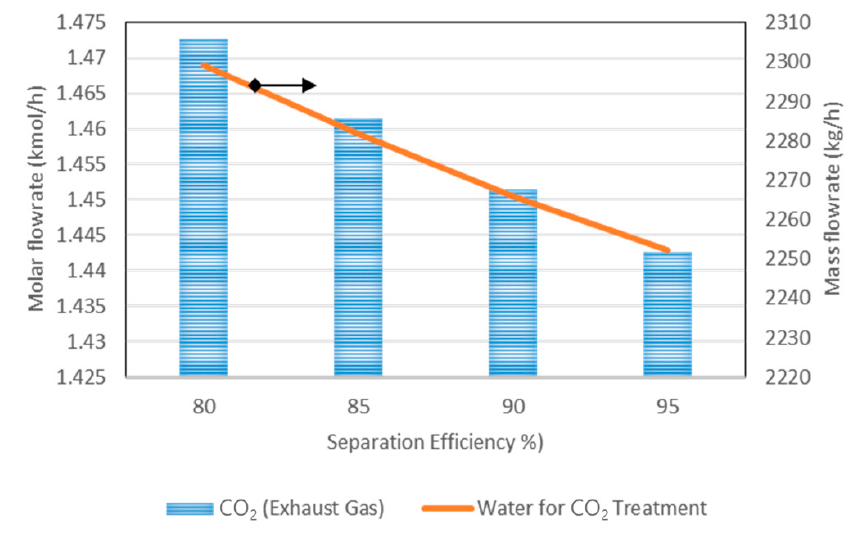
Figure 14. E ff ect of Separation e ffi ciency on CO 2 generated and water to solve CO Figure 14. Effect of Separation efficiency on CO 2 generated and water to solve CO 2.